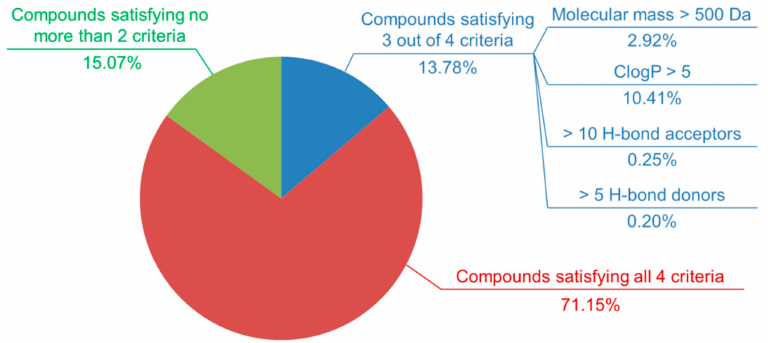
Figure 2. Partition of compounds tested in PubChem bioactivity assays according to four criteria of the Lipinski’s rule of five. It is observed that most compounds (over 70%) satisfy all criteria. Nearly 85% of deposited compounds violate no more than one criterion. On the other hand, only 0.1% of all compounds (over 130,000) do not satisfy any criterion. Statistics were updated as of 30 April